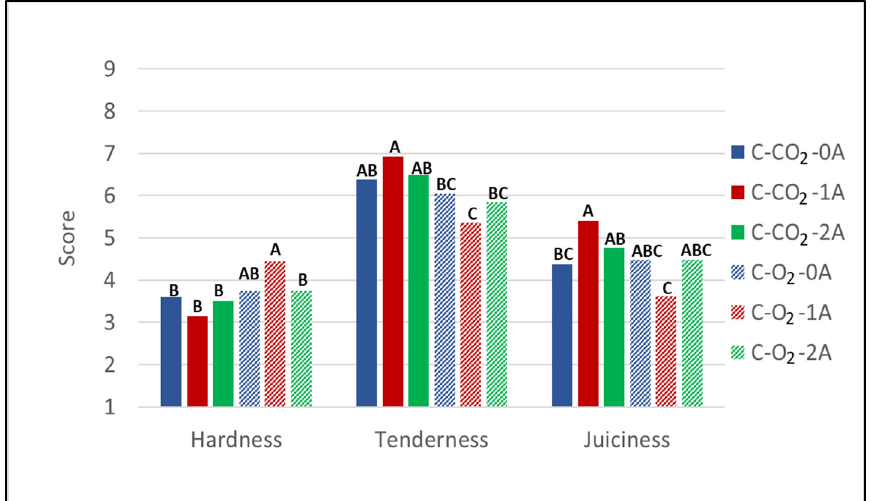
Figure 3. Sensory intensity scores (scale 1–9) for the textural attributes hardness, tenderness, and juiciness of heat-treated chicken breast fillets (C) stored for 14 days in modified atmospheres of 60% CO 2 /40% N 2 (C-CO 2 ) and 75% O 2 /25% CO 2 (C-O 2 ) with 0, 1, or 2 liquid absorbent pads (0A, 1A, 2A). g/p ratio for all samples was 1.8 (Experiment 1).